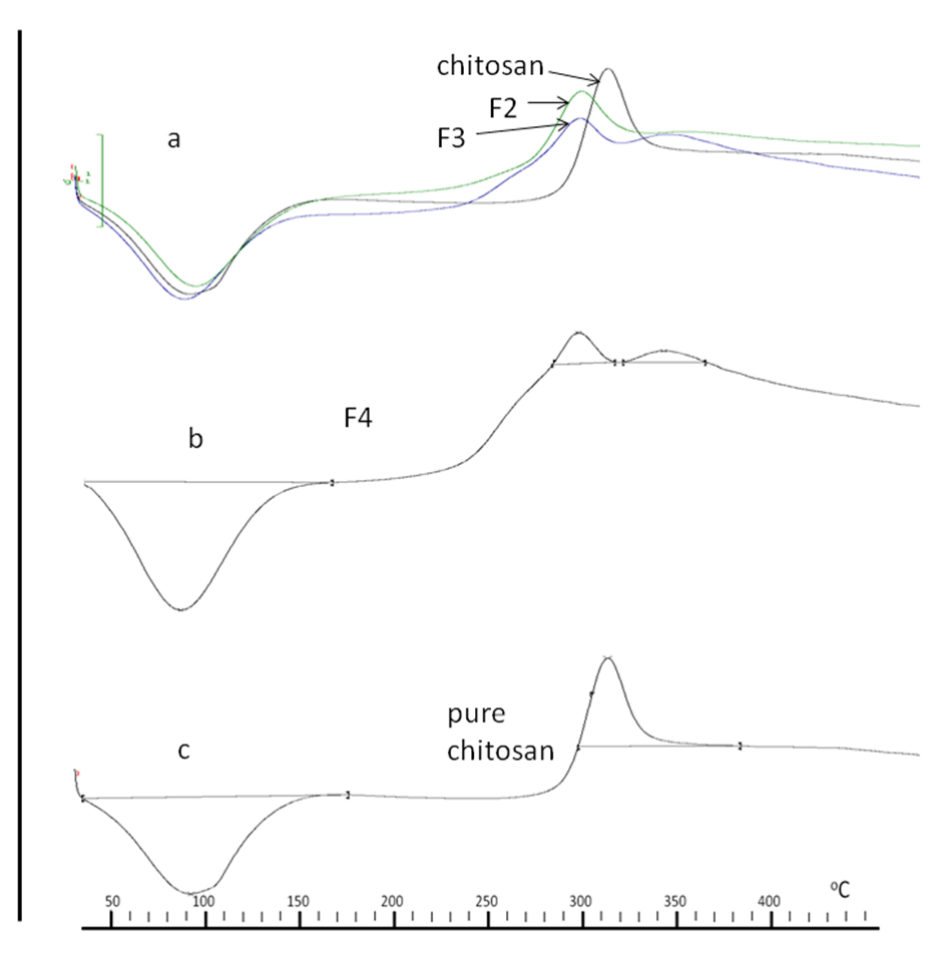
Figure 5. DSC thermograms of chitosan and conjugates ( a ) F2, F3 and chitosan, ( b ) F4 and ( c )